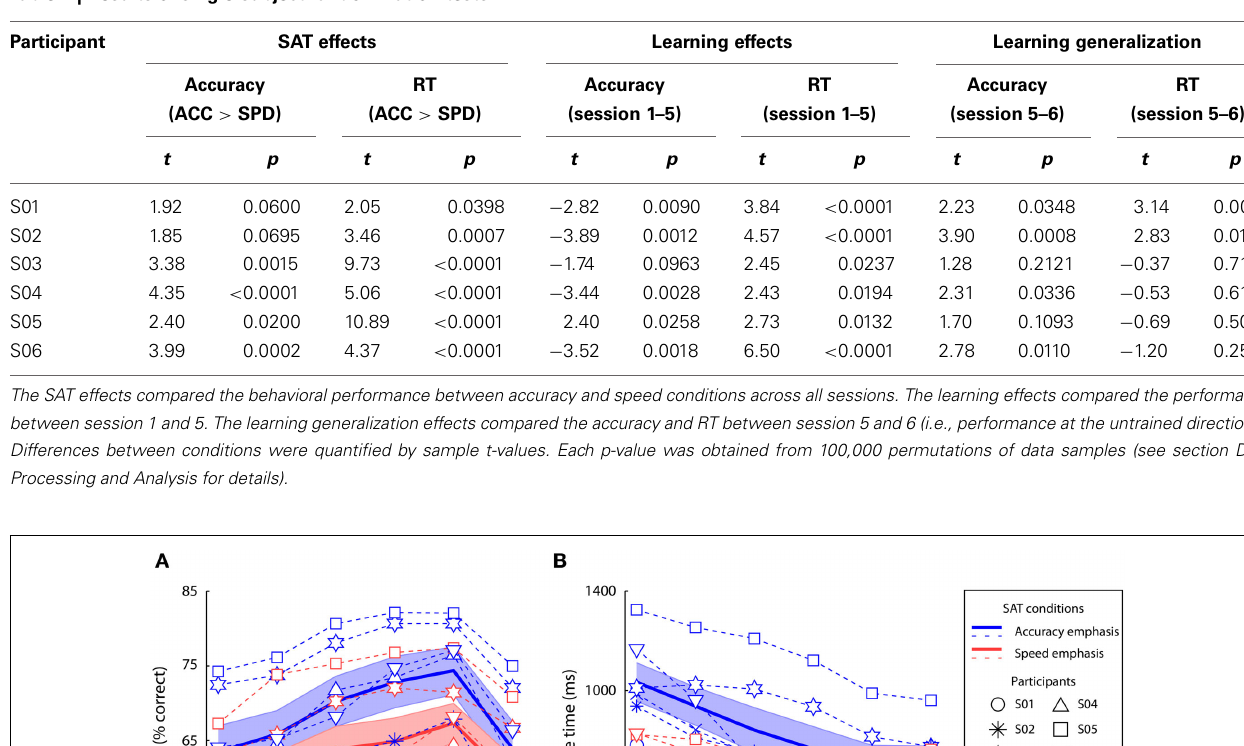
Table 1 | Results of single-subject randomization tests.